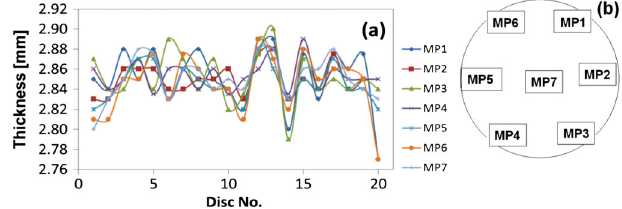
FIG. 1. Thickness distribution (a) and measurement locations (b) in the LG disks of the W. C. HERAEUS with approximately 300 mm diameter. Tolerances are more narrow than those required by the XFEL Specification ( 2 : 8 (cid:1) 0 : 1